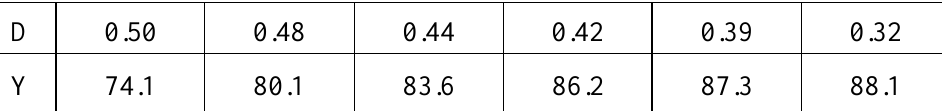
Table 4. Influence of the raw material ratio (D) on Y